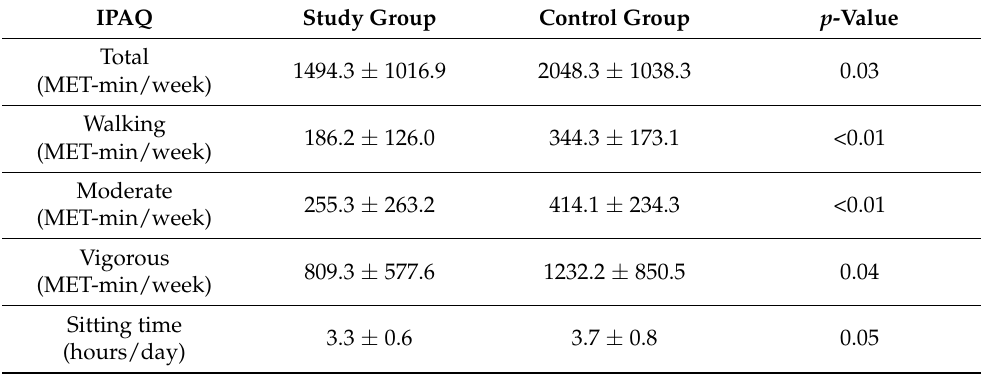
Table 2. Physical activity in the two groups. MET: metabolic equivalent of task. IPAQ: International Physical Activity